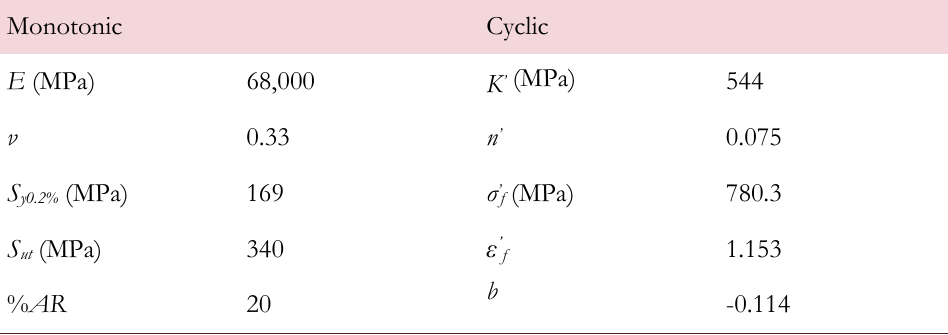
Table 1: Monotonic and cyclic properties Al5083 aluminum